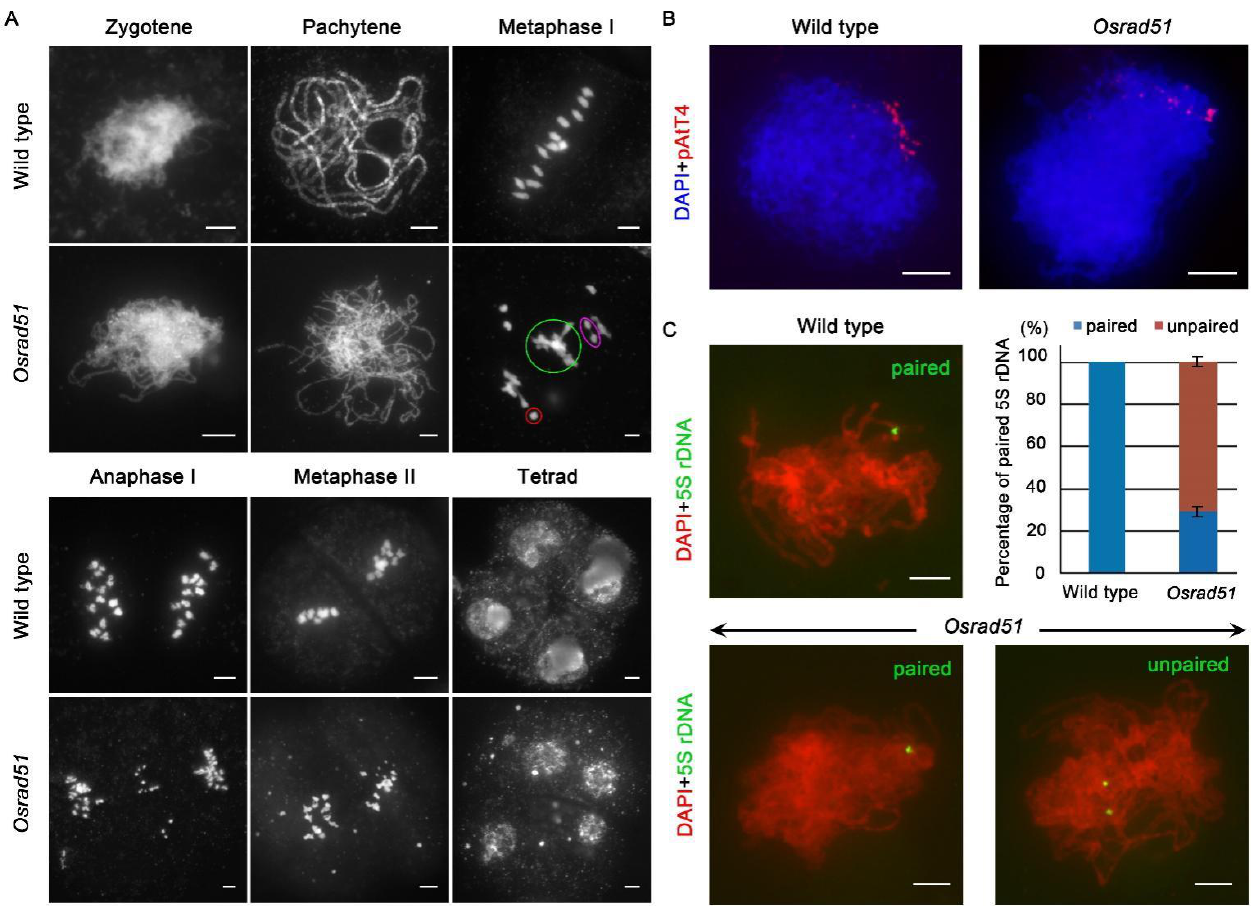
Figure 2. OsRAD51 deficiency causes severe meiotic chromosomal defects. ( A ). Meiotic chromosome behavior in both wild-type and Osrad51 PMCs. The red circle indicates univalent; the green circle indicates multivalent; the purple circle shows a separating bivalent. ( B ). Bouquet formation was analyzed using FISH with the telomere-specific pAtT4 probe (red) in the wild-type and Osrad51 PMCs. Chromosomes were stained with DAPI (4 (cid:48) ,6-diamidino-2-phenylindole, blue). ( C ). Chromosome pairing status in the wild-type and Osrad51 mutant. The probe was 5S rDNA (green). Chromosomes were stained with DAPI (red). Upper left panel, fully paired pachytene chromosomes in wild type; upper right panel, histogram of observed cells according to their pairing status; lower left panel, the Osrad51 PMCs show paired probe signals; lower right panel, the Osrad51 PMCs show unpaired probe signals. Bars, 5 µ